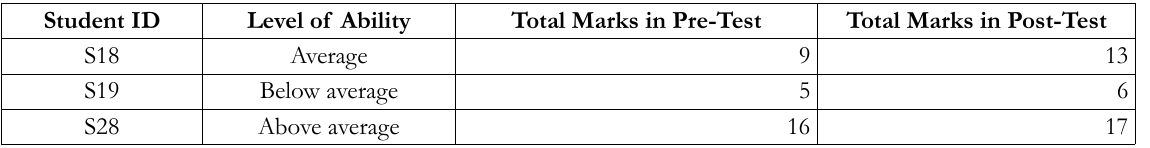
Table 13. Students who improved in their